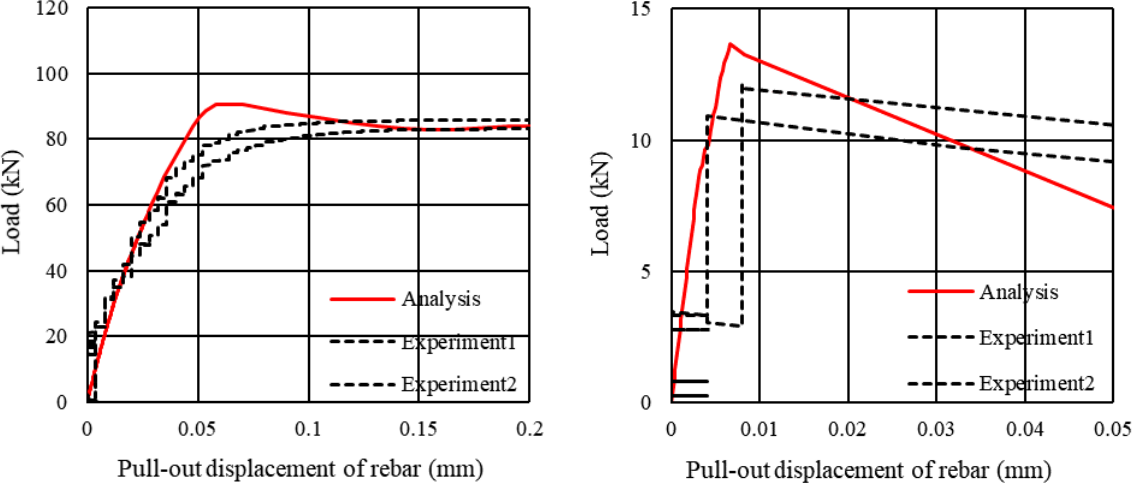
Figure 11. Rebar pull-out test reproduction analysis results ( left : threaded bar, right : round PC bar).